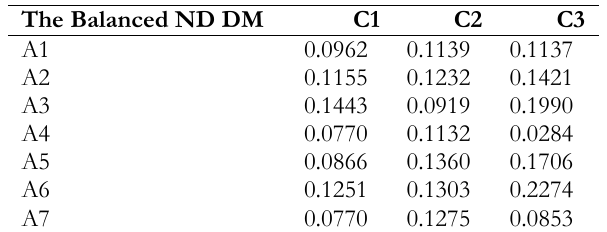
Table 24. The balanced ND decision